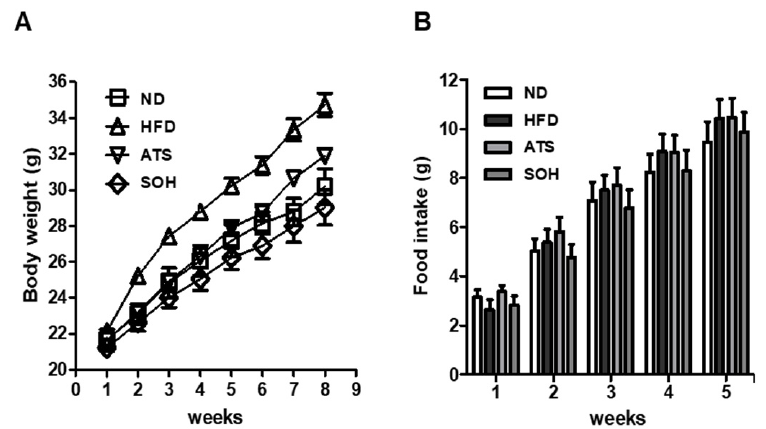
Figure 4. Body weight and food intake. Mice were fed a high-fat diet (HFD) and normal food from one week of age. Body weight and food intake were recorded weekly. ( A ) body weight, ( B ) food intake.